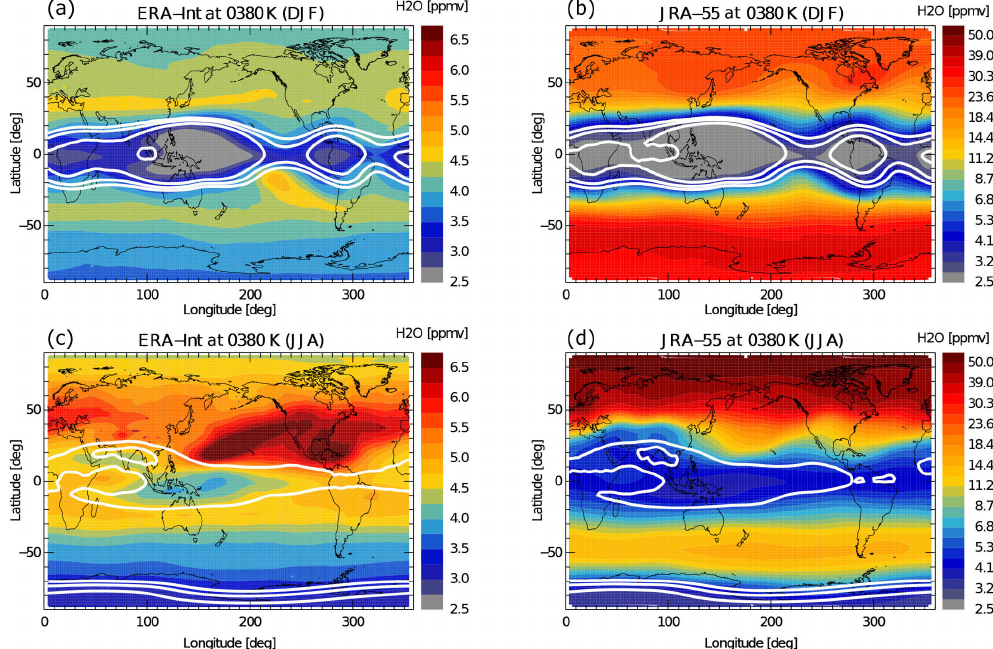
Figure 17. Seasonal mean water vapour distribution averaged over the period from 2004 to 2013 at the potential temperature level of 380K; DJF indicates winter (a, b) , and JJA summer periods (c, d) . Shown data are from both reanalysis, ERA-Interim and JRA-55 data. The white lines are constant temperature levels from corresponding reanalysis datasets (191, 193, 195K). Note the logarithmic colour bar for